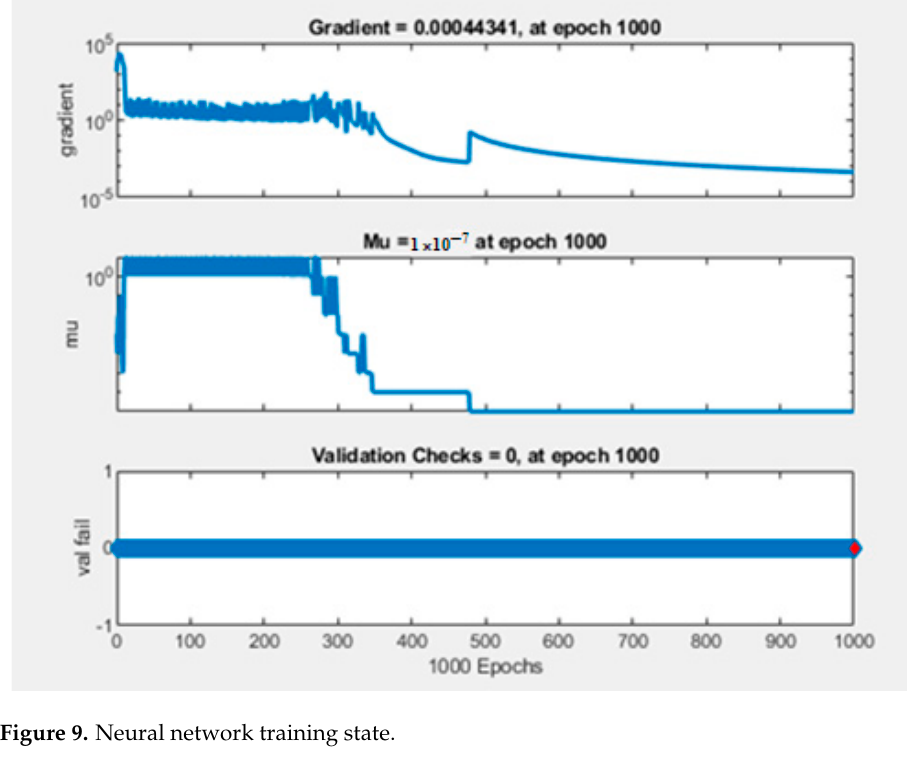
Figure 9. Neural network training state.